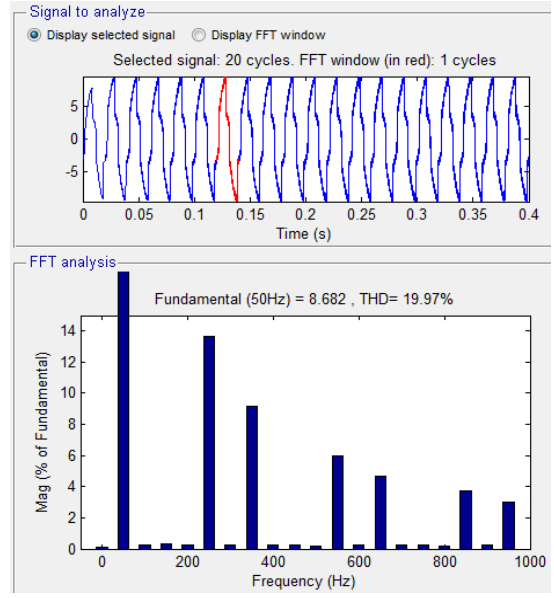
Figure 15. THD in load current